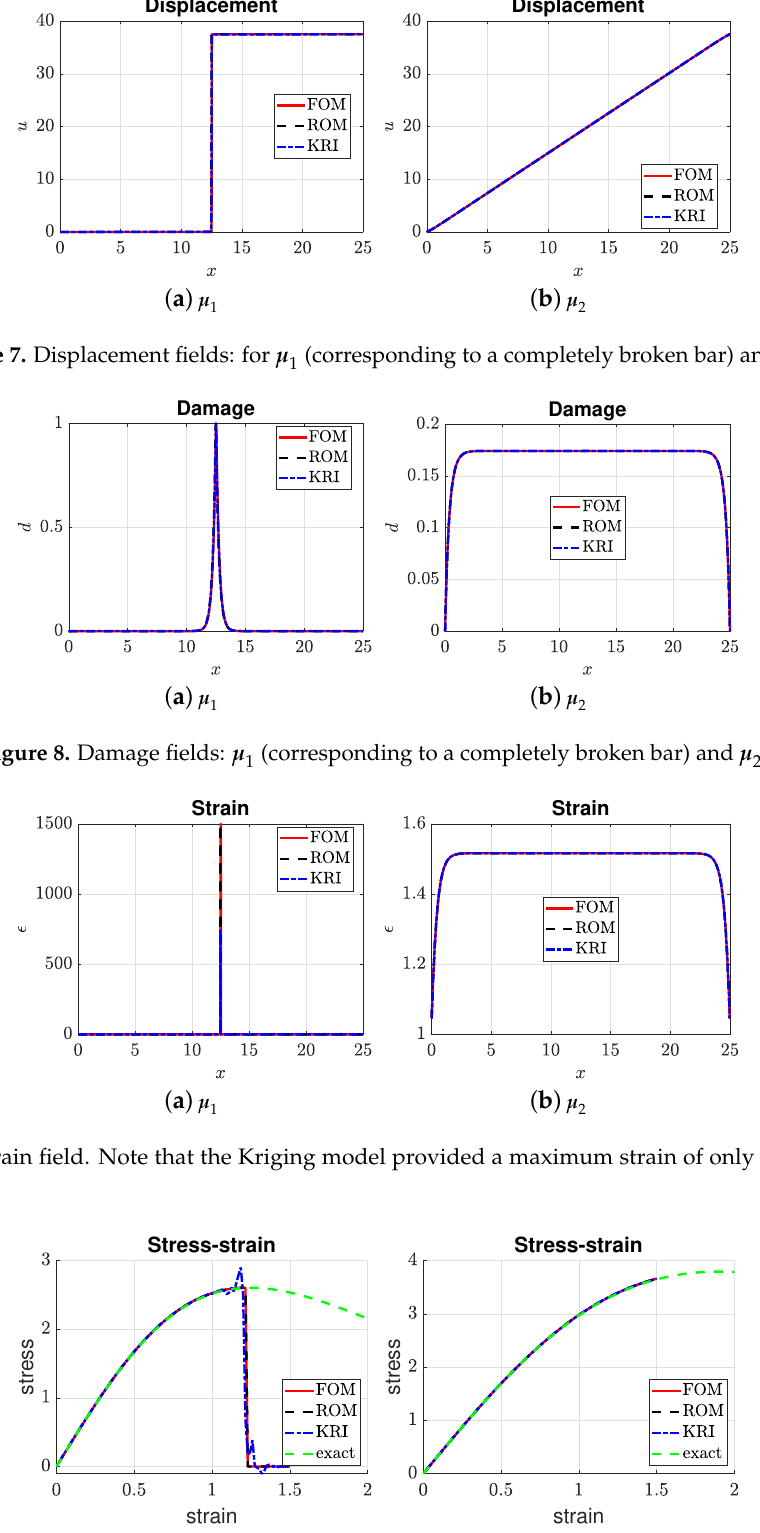
Figure 10. Stress-strain curve. We note the oscillations around the localization point for the Kriging model ( a ). The exact homogeneous stress-strain (valid up to crack initiation at a strain of 1.25) is given in Appendix